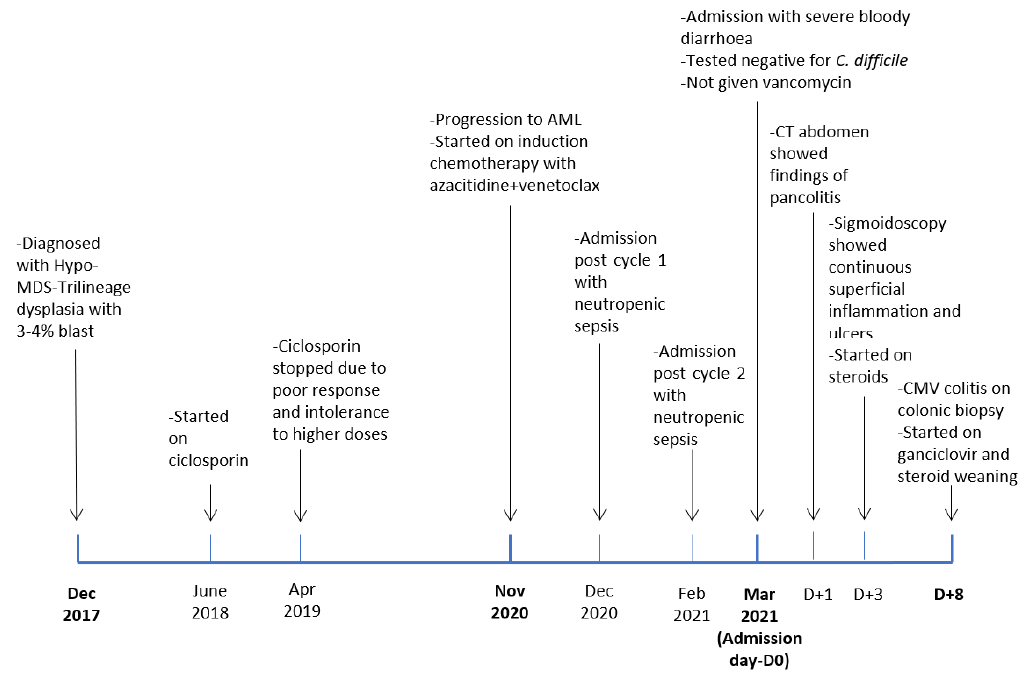
Figure 4. Timeline of events.